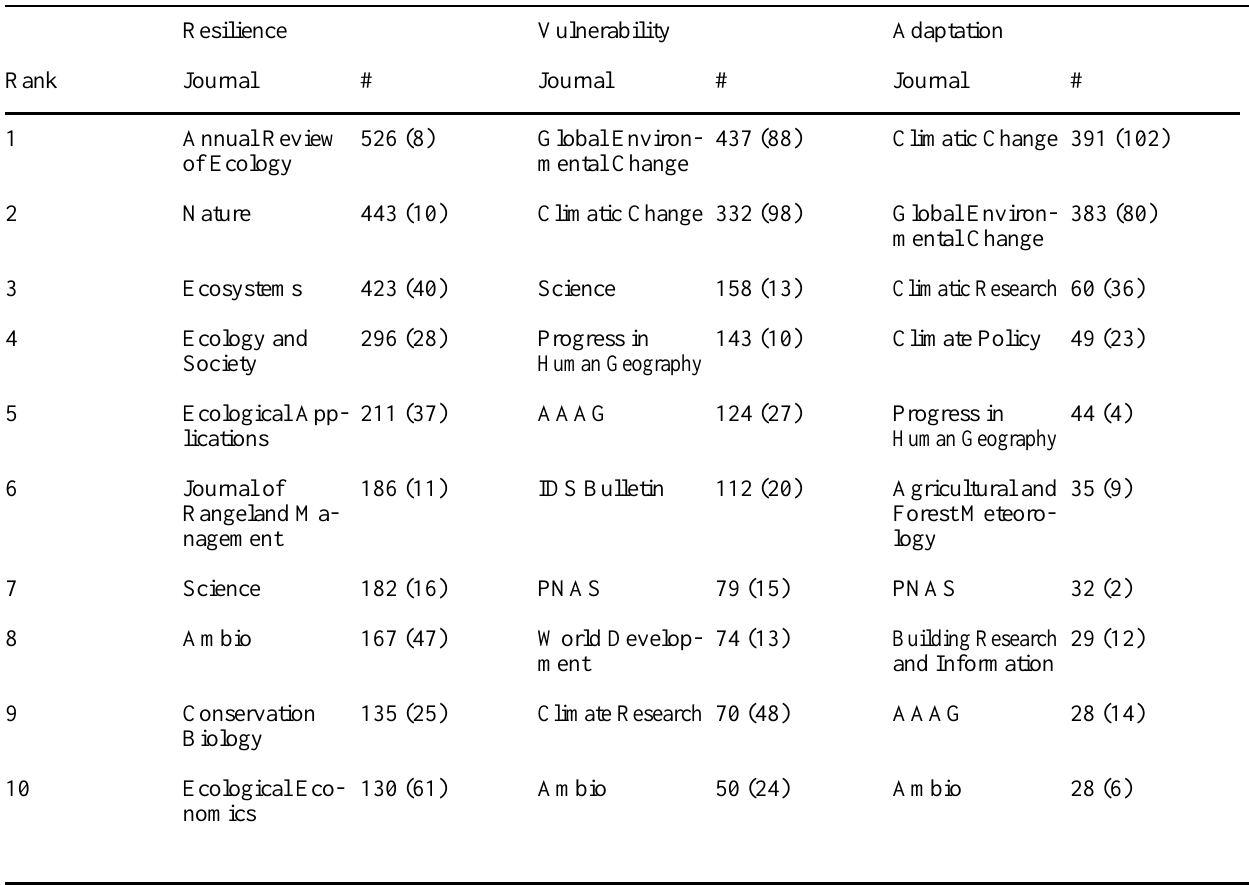
Table 4. The top ten journals with the greatest number of citations in resilience, vulnerability, and adaptation over the period 1977–2007. (The # symbol refers to the number of received citations, the figures between parentheses are the number of articles in that journal in that knowledge domain.) Resilience